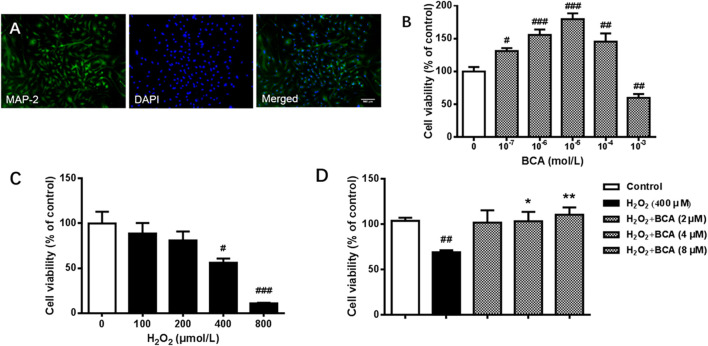
Identification of neurons and determination of cell viability in primary cultures of rat hippocampal neurons. (A) Staining of antibodies against MAP-2, a neuron-specific marker, and/or DAPI, a nuclear marker, in hippocampal neurons. A purity of >90% were identified. (B) Cell viability in response to 24-h incubation with increasing concentrations (10−7 - 10−3 mol/L) of BCA. (C) Cell vitality in response to 12-h incubation with increasing concentrations of (100–800 µM) of H2O2. (D) Effects of BCA on cell viability in hippocampal neurons treated with H2O2 (400 µM) for 12 h. BCA was added 24 h before H2O2. Values shown are means ± S.E. #
p < 0.05, ##
p < 0.01, ###
p < 0.001 vs. control; *p < 0.05, **p < 0.01 vs. H2O2 alone; n = 4–6.